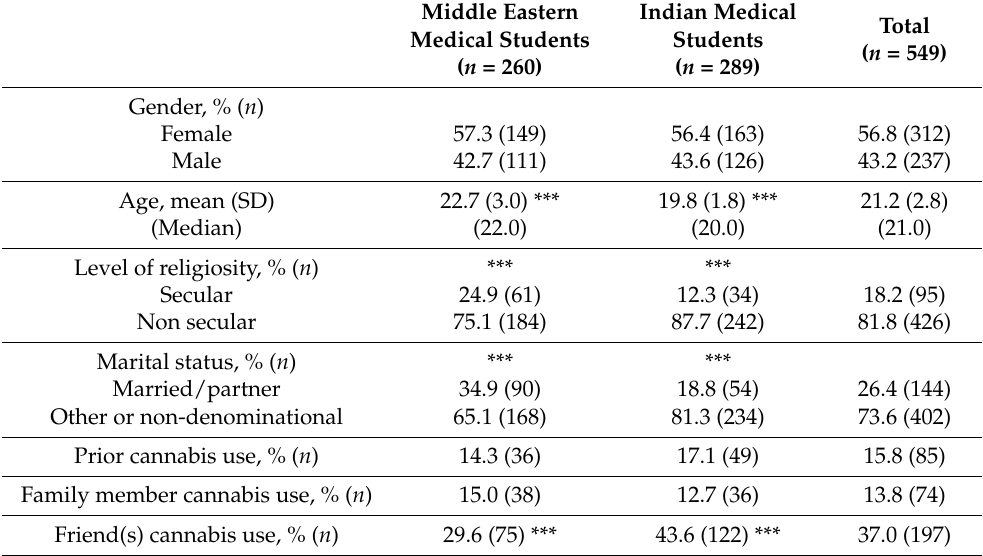
Table 1. Survey respondent background characteristics.